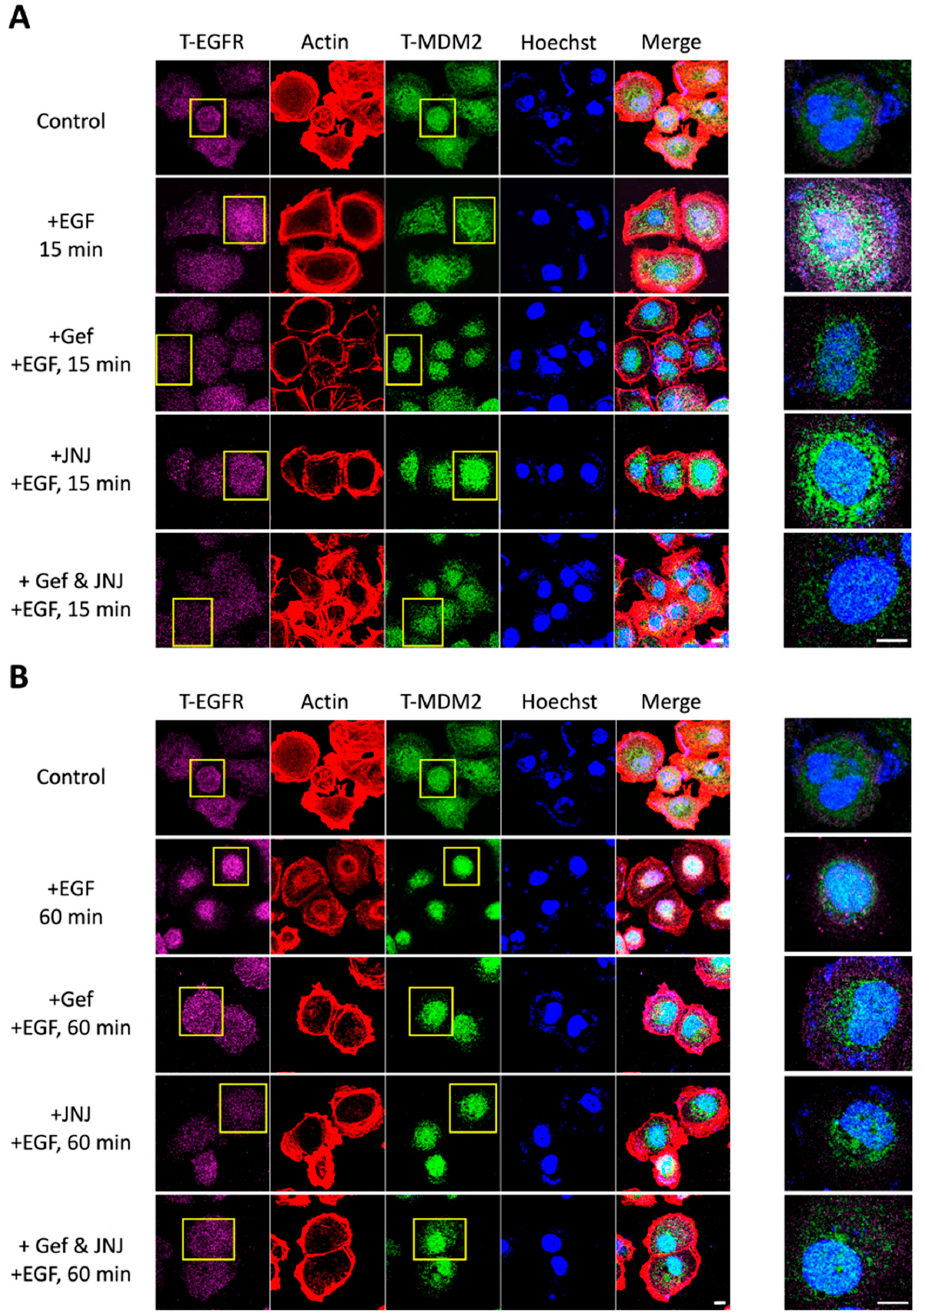
Figure 3. Cytonuclear trafficking of EGFR and MDM2 would be disrupted under combined inhibition of EGFR and MDM2 by gefitinib and JNJ. OVCAR3 cells were serum-starved while treated with or without the inhibitors under different conditions (i.e., 14.4 µ M gefitinib, 1.4 µ M JNJ, or 1 µ M gefitinib + 1 µ M JNJ; the IC 50 concentration was derived from our previous study [30]) for 24 h. The cells were then stimulated with EGF (50 ng/mL) for 0 (control), 15 or 60 min. ( A ) Confocal image analysis demonstrated that EGFR and MDM2, which were initially distributed in the cytoplasm, converged and translocated in sync to the periphery of the nucleus after 15 min of EGF stimulation. However, the convergence pattern of EGFR was disrupted after 24 h of treatment with gefitinib, JNJ, or their combination. In comparison, the convergence pattern of MDM2 was disrupted only under the combined treatment of gefitinib and JNJ. ( B ) After 60 min of EGF stimulation, EGFR and MDM2 translocated completely into the nucleus. With combined treatment of gefitinib and JNJ for 24 h, some MDM2 could be detected again in the cytoplasm. The cells were immunostained with anti-EGFR antibody (shown in purple) and anti-MDM2 antibody (shown in green); actin in red and DNA in blue were shown by Phalloidin staining and Hoechst staining, respectively. The right images were enlarged view of the yellow boxed region. The scale bar represented 10 µ m. (Gef: gefitinib; JNJ: